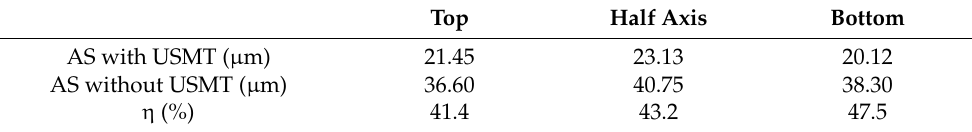
Table 3. Reduction rate ( η ) of the area fraction (AF) of the coarsening precipitate phase.